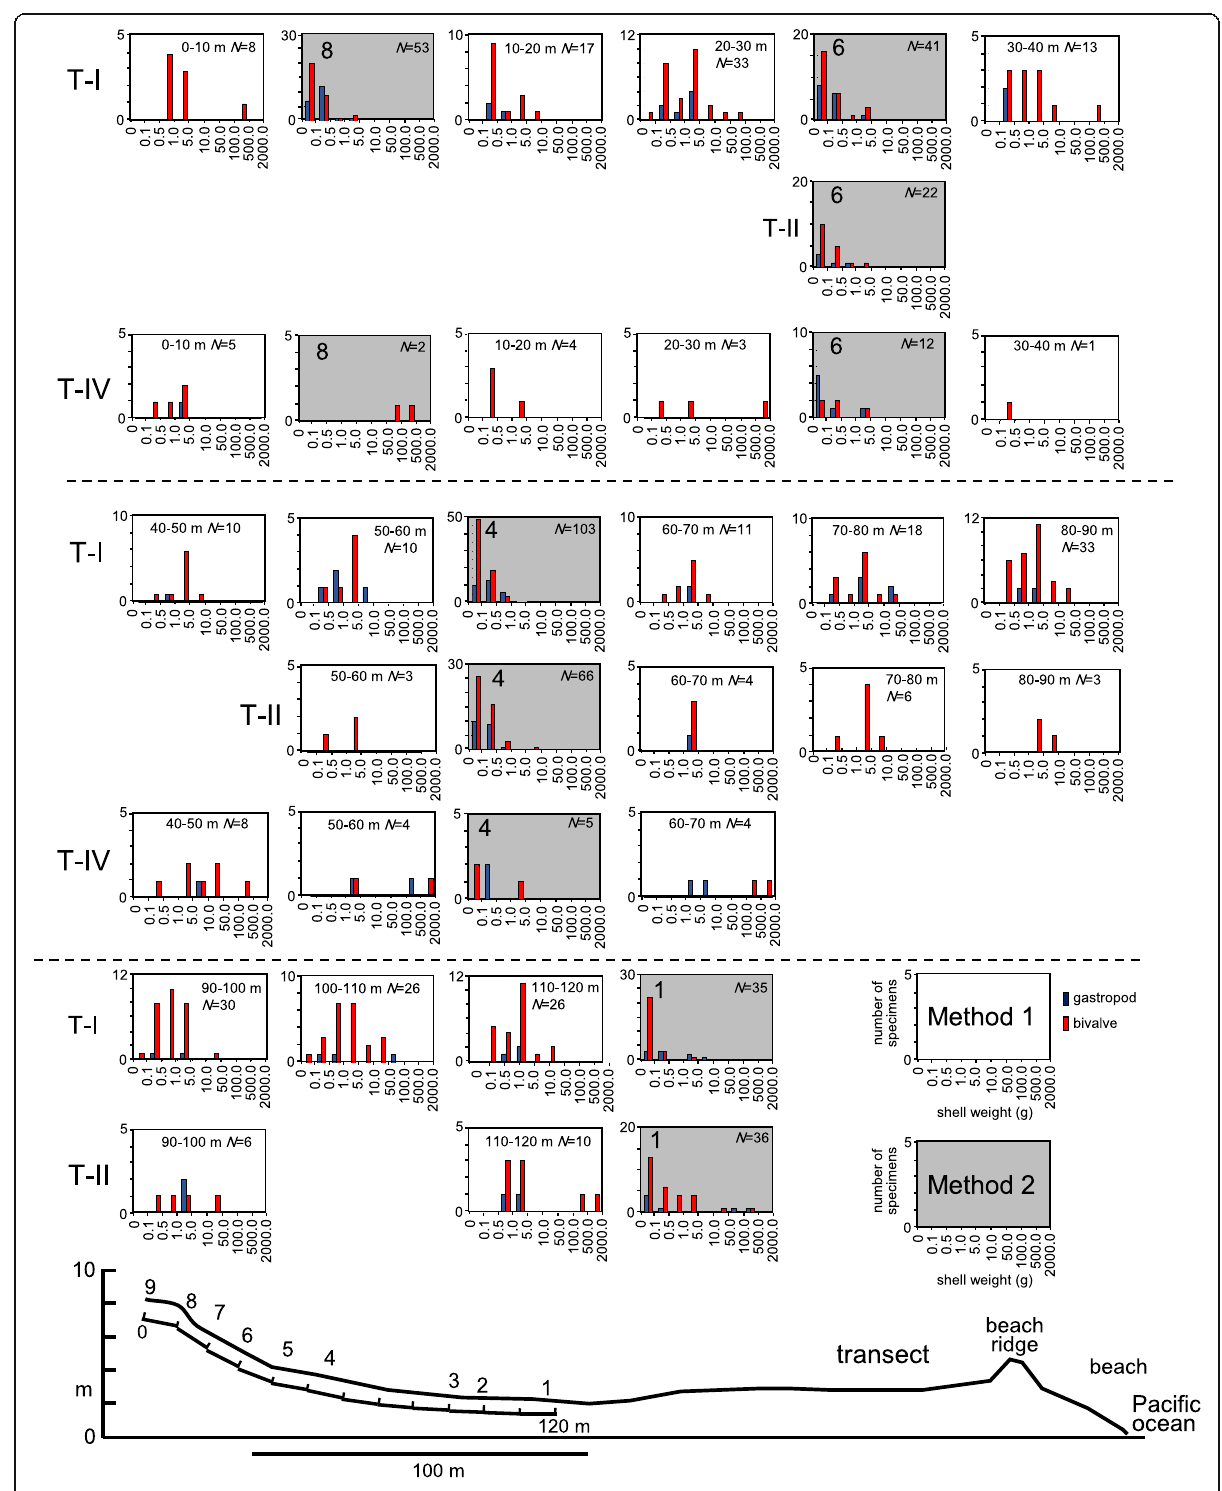
Fig. 5 Histograms of shell weights of specimens collected from the tsunami deposits in a trench using methods 1 and